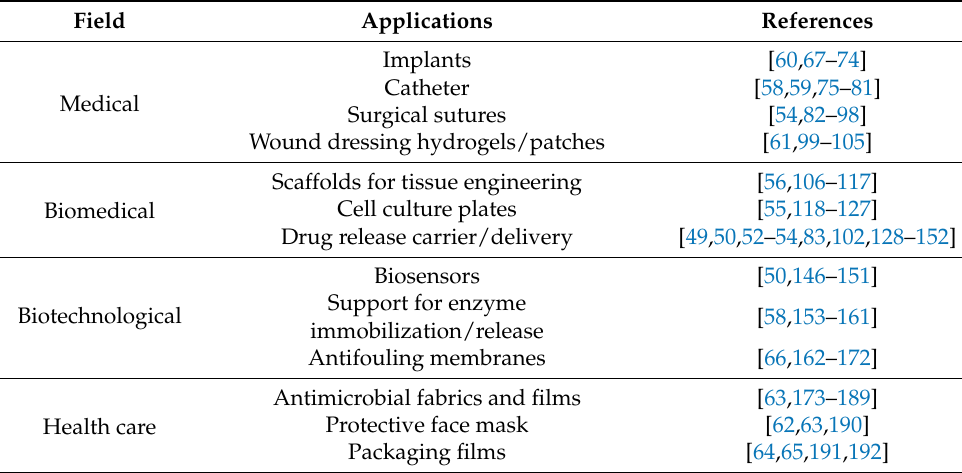
Table 1. Classification of FPBMs prepared by